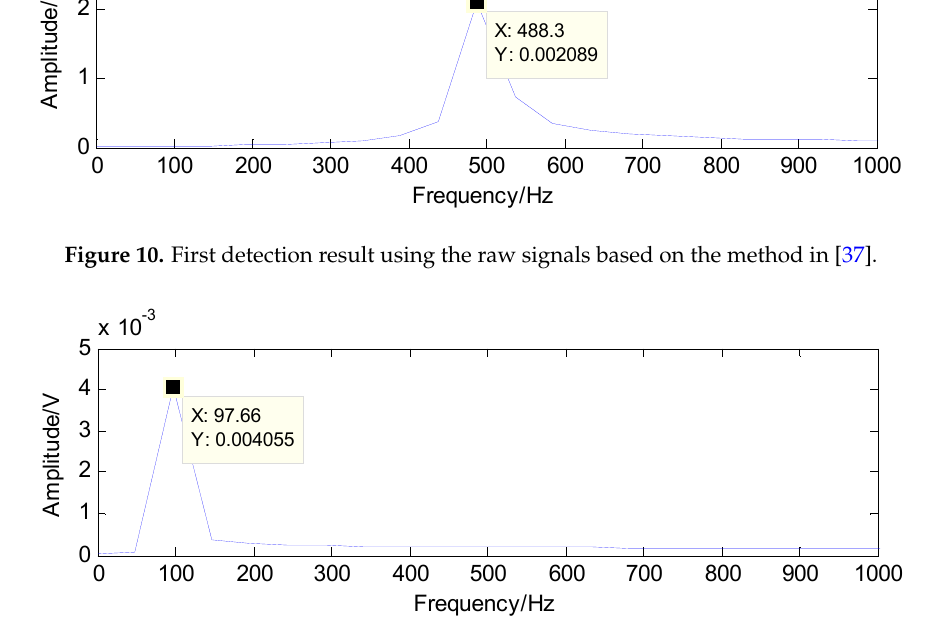
Figure 11. Second detection result using the raw signals based on the method in [37].